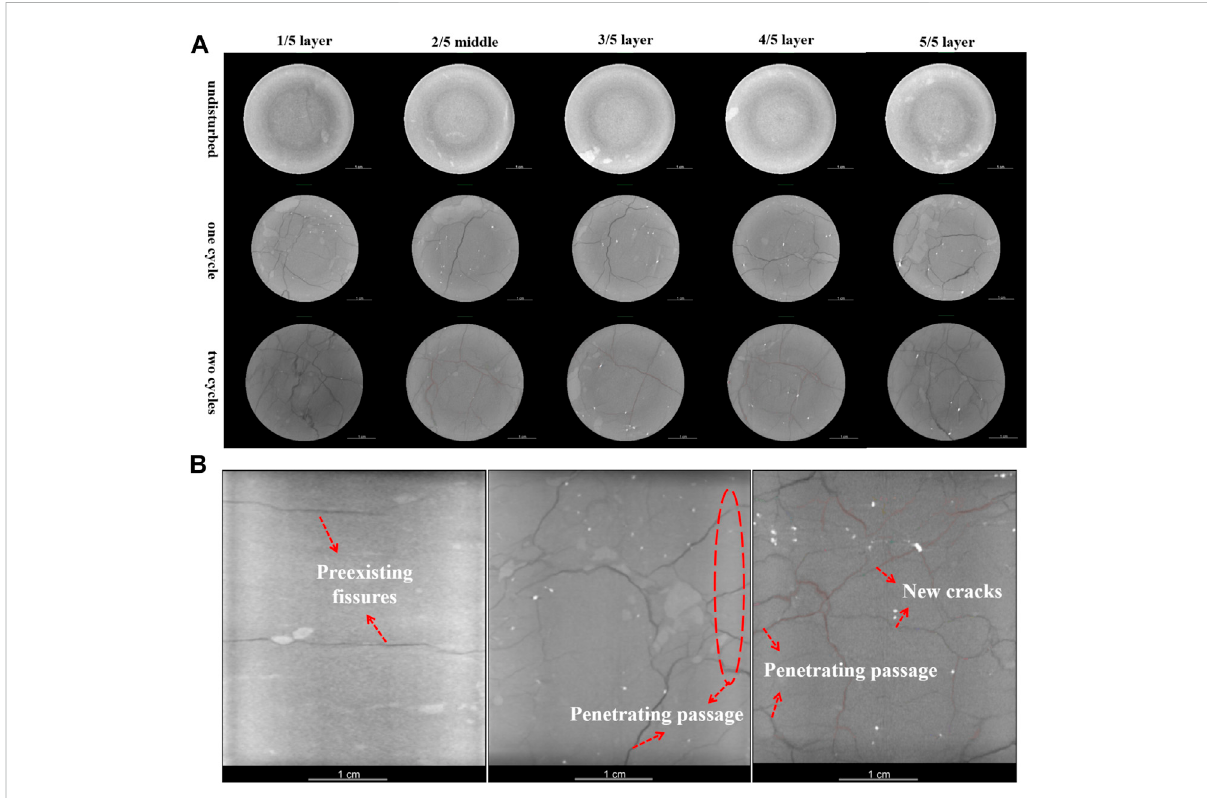
Figure 4C~D presented the results of rapid dehumidi fi cation, which was closer to the standard “ n " curve. The swelling process will not be repeated here. From Figure 4C~D, the fi rst shrinkage strain of samples YQ-1 and YQ-2 was roughly stable at 170.4 h. The entire dehumidi fi ed process lasted about 55 h, which was much smaller than the